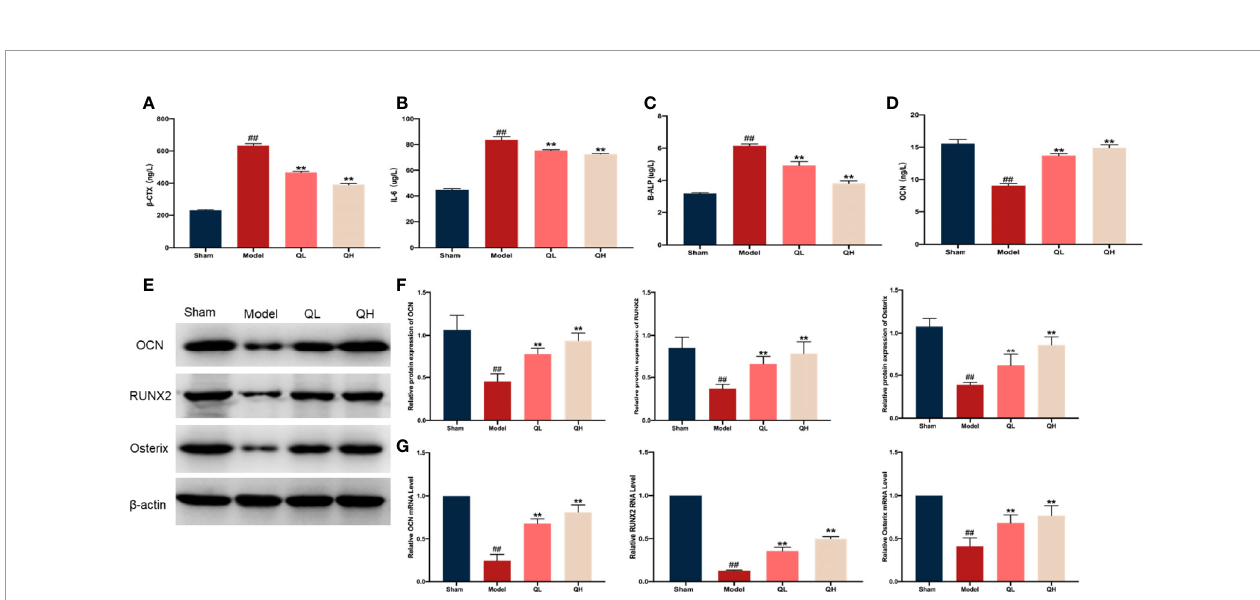
FIGURE 6 | Effects of quercetin on bone metabolism in mice that underwent orchiectomy. The serum levels of markers of bone resorption including (A) b - isomerized C-terminal telopeptides ( b -CTX), (B) interleukin 6 (IL-6), (C) bone alkaline phosphatase (B-ALP), and (D) osteocalcin (OCN). (E) The expression of bone formation proteins in the tibia, including OCN, RUNX2, and Osterix. (F) Semi-quanti fi cation of OCN, RUNX2, and Osterix by Image J software. (G) The mRNA expression of OCN, RUNX2, and Osterix in tibia. ## p< 0.01 vs. sham group; ** p< 0.01 vs. model